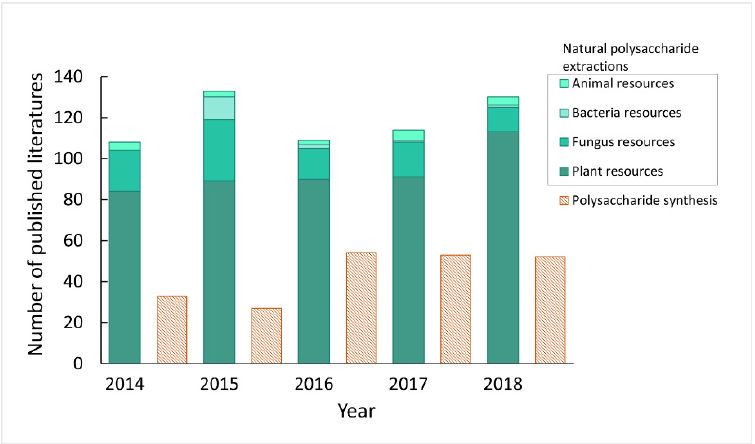
Figure 2. Literature analysis of natural polysaccharide extractions and polysaccharide synthesis with the statistical data coming from the web of science.